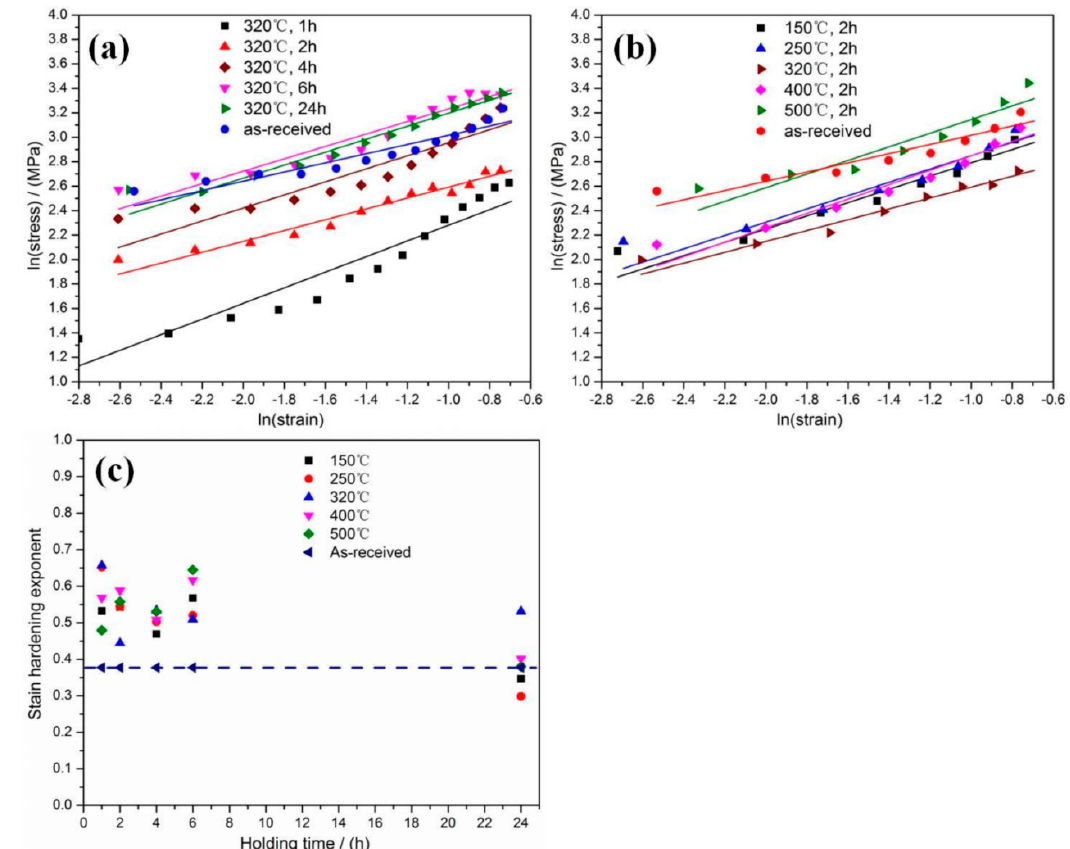
Figure 10. The ln(stress)-ln(strain) curves of the foams heated at 320 °C ( a ), held for 2 h ( b ) and the strain hardening exponents of foams ( c ). Table 4. The value of K and n of the foams heated at 320 °C.